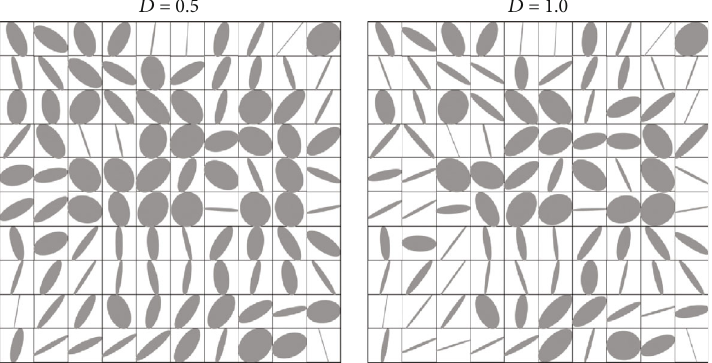
Figure 10: Equivalent permeability ellipse for correlated fracture aperture and length models for D =0.5 and D